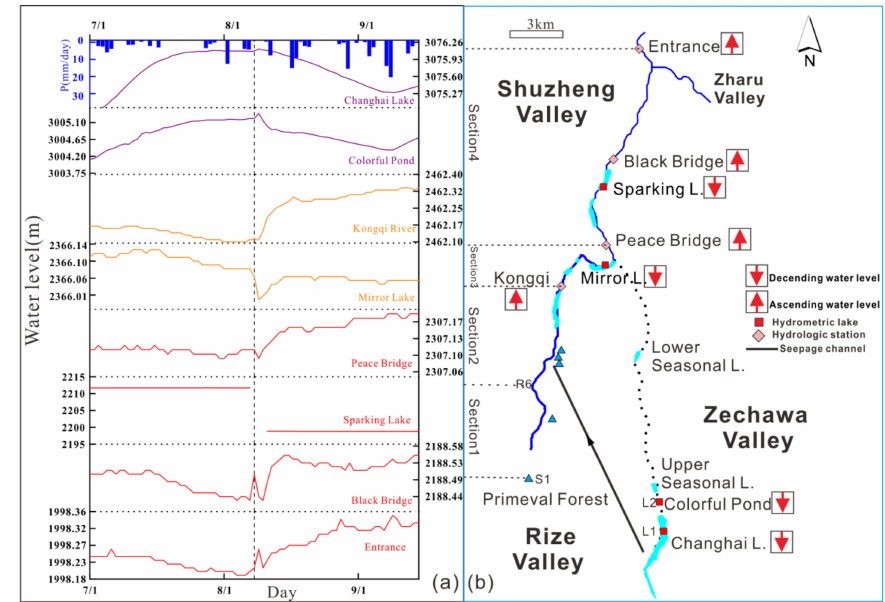
Figure 3. ( a ) Water levels of four hydrometric lakes and four hydrologic stations in three valleys. ( b ) Regional water level changes induced by the earthquake. The dashed black line represents the Mw6.5 earthquake, and the blue column refers to the amount of precipitation. The water level data are presented in Table S1 of the Electronic Supplementary Materials